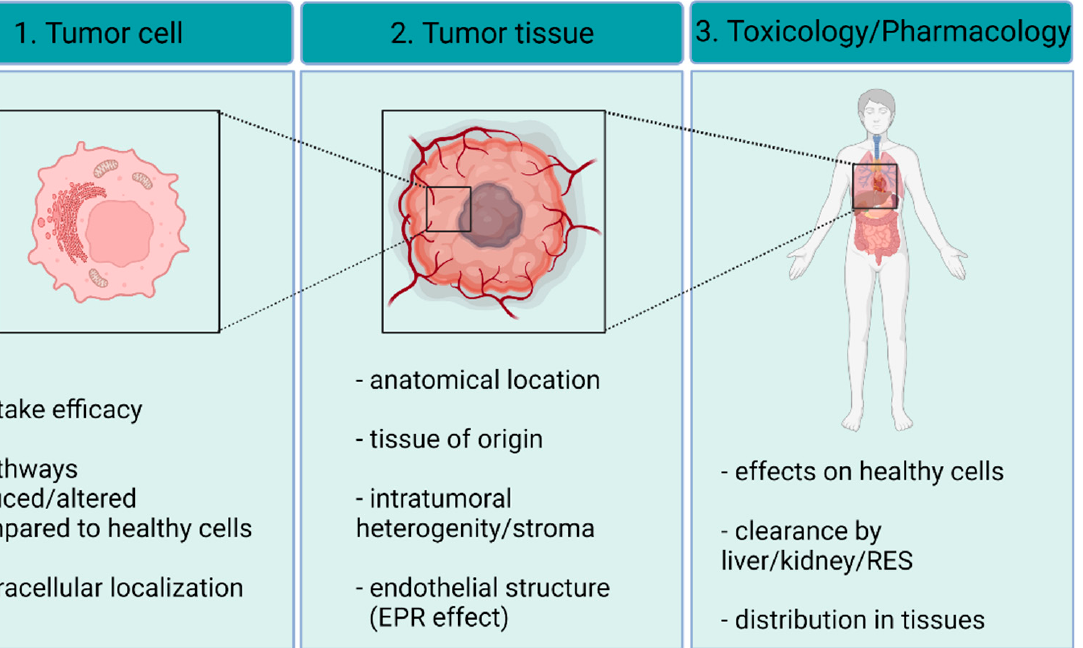
Figure 1. Before their clinical application, detailed understanding of the AgNP-triggered effects on the level of single cells, cancer tissues and organs is mandatory. In this review, we discuss the latest knowledge accumulated on AgNP–cancer interactions at the abovementioned three organization levels. The figure was created with BioRender.com.